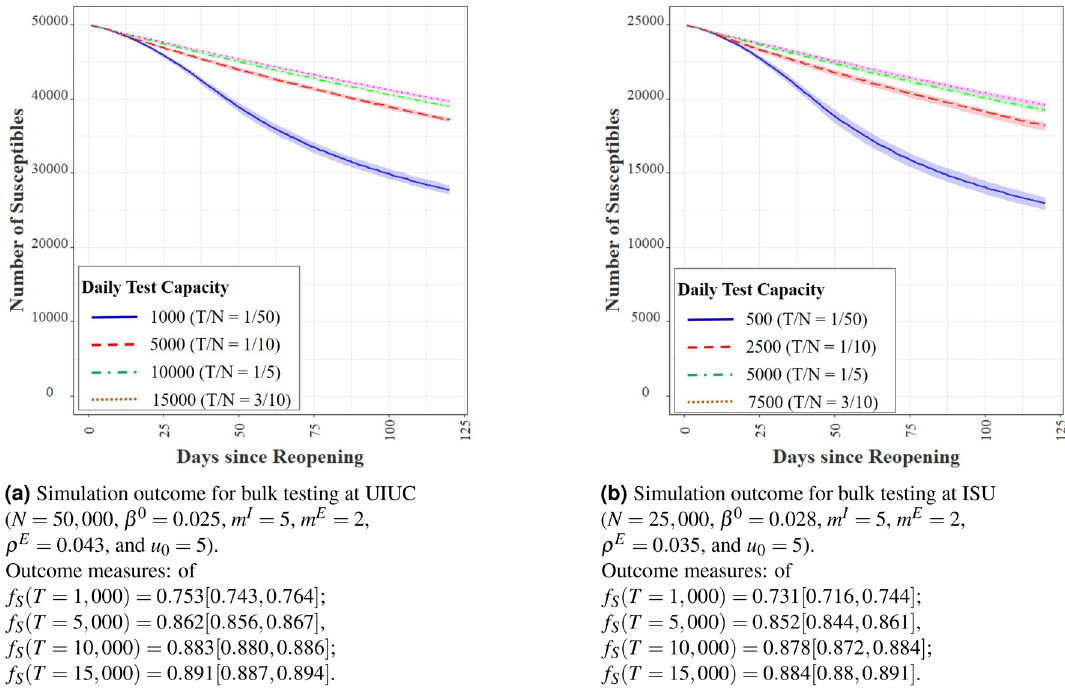
Figure 4. Comparison of the effect of bulk testing at UIUC and